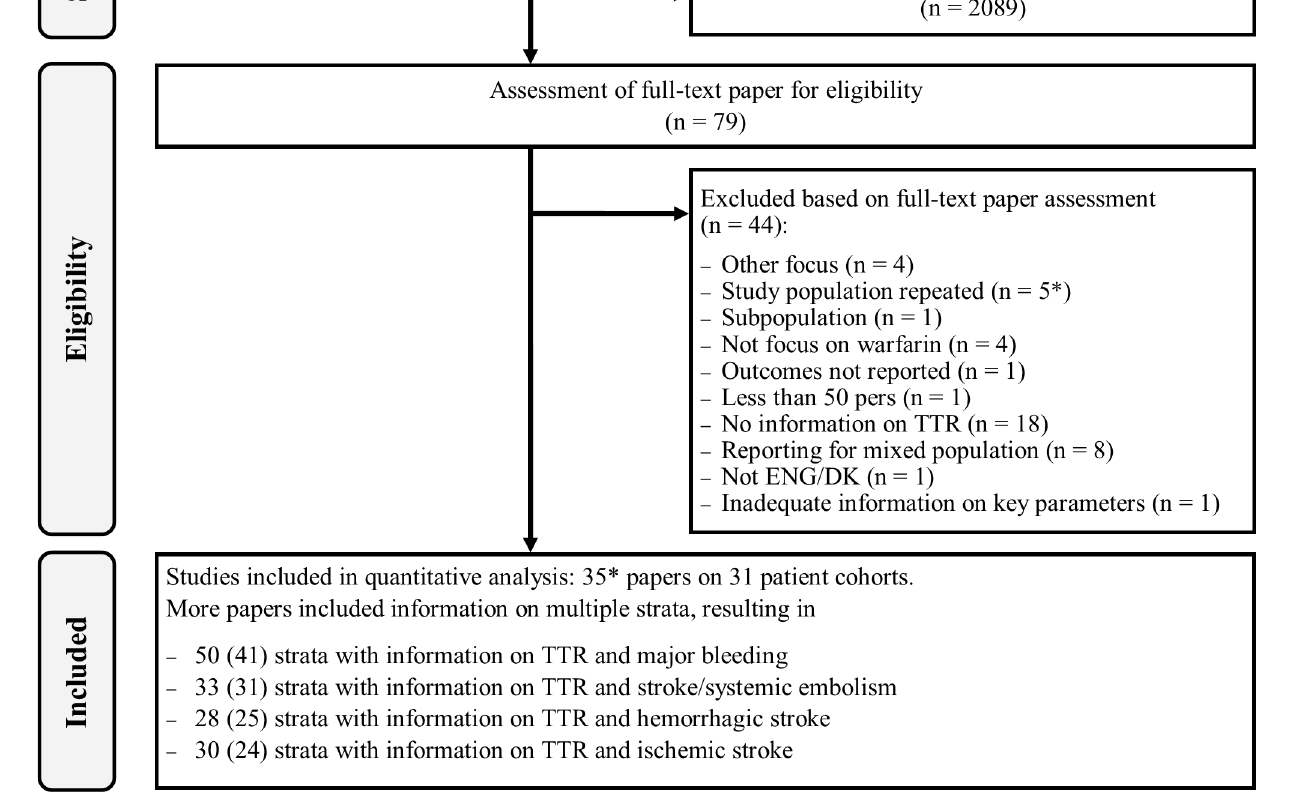
PLOS ONE | https://doi.org/10.1371/journal.pone.0188482 November20,